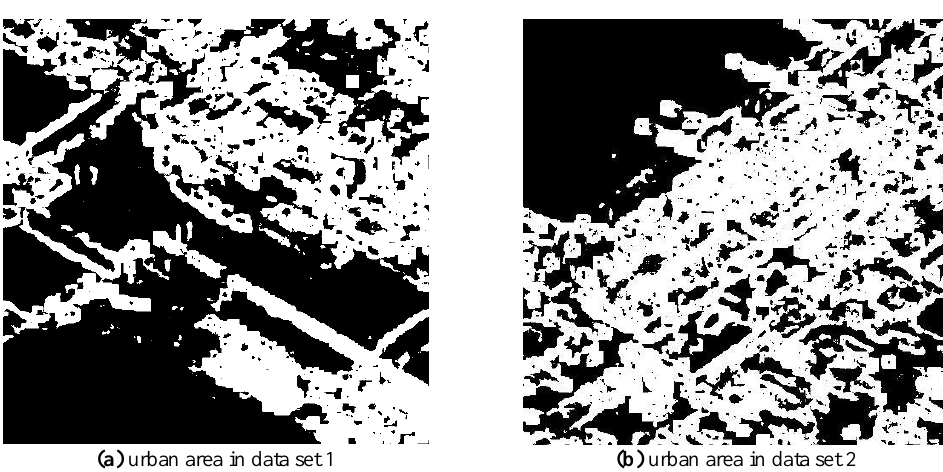
Fig.3 Urban extraction maps of the study areas using the proposed